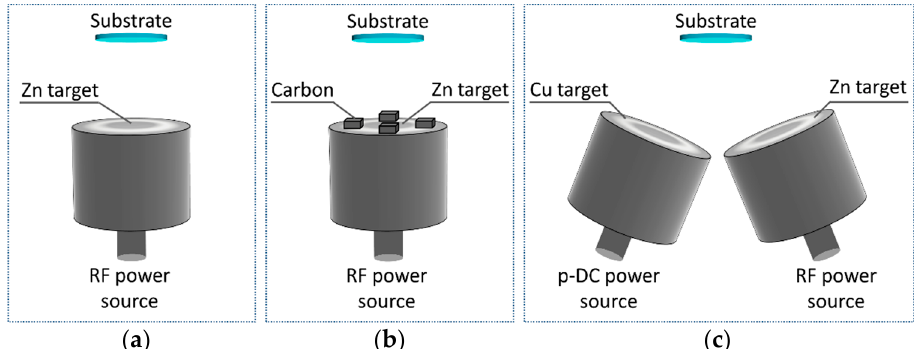
Figure 7. Experimental schemes for the deposition of three types of ZnO based films: ( a ) metallic Zn phase rich ZnO oxide (m-ZnO); ( b ) carbon-doped ZnO (C-ZnO); and ( c ) copper-doped ZnO (Cu-ZnO).